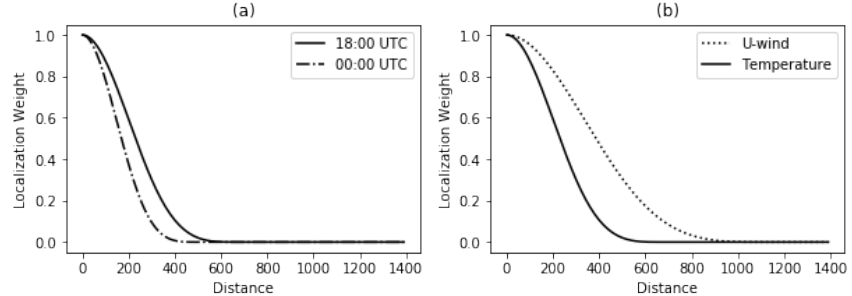
Figure 12. The adaptive localization function of temperature at different times, and of temperature and zonal wind at 18:00 UTC on 26 September